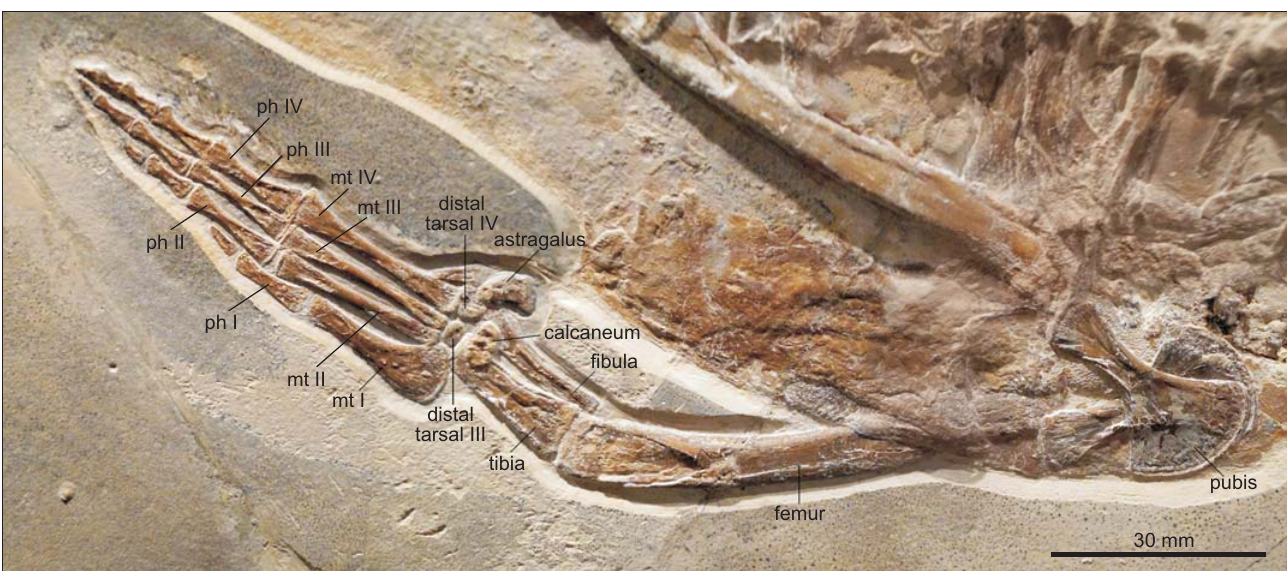
Fig. 7. Metriorhynchid thalattosuchian Cricosaurus bambergensis sp. nov. (NKMB-P-Watt14/274) holotype, late Kimmeridgian of Wattendorf (southern Germany). Hindlimb and pelvic girdle. Abbreviations: mt, metatarsals; ph,